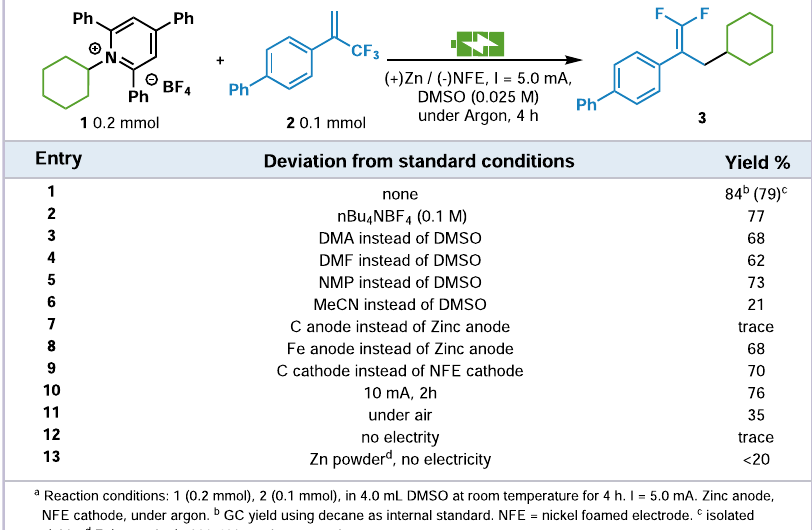
Fig. 2 Optimization of the reaction conditions. Deviation from the standard conditions including electrolyte, solvent, electrode, current, additive and the corresponding yields of the coupling